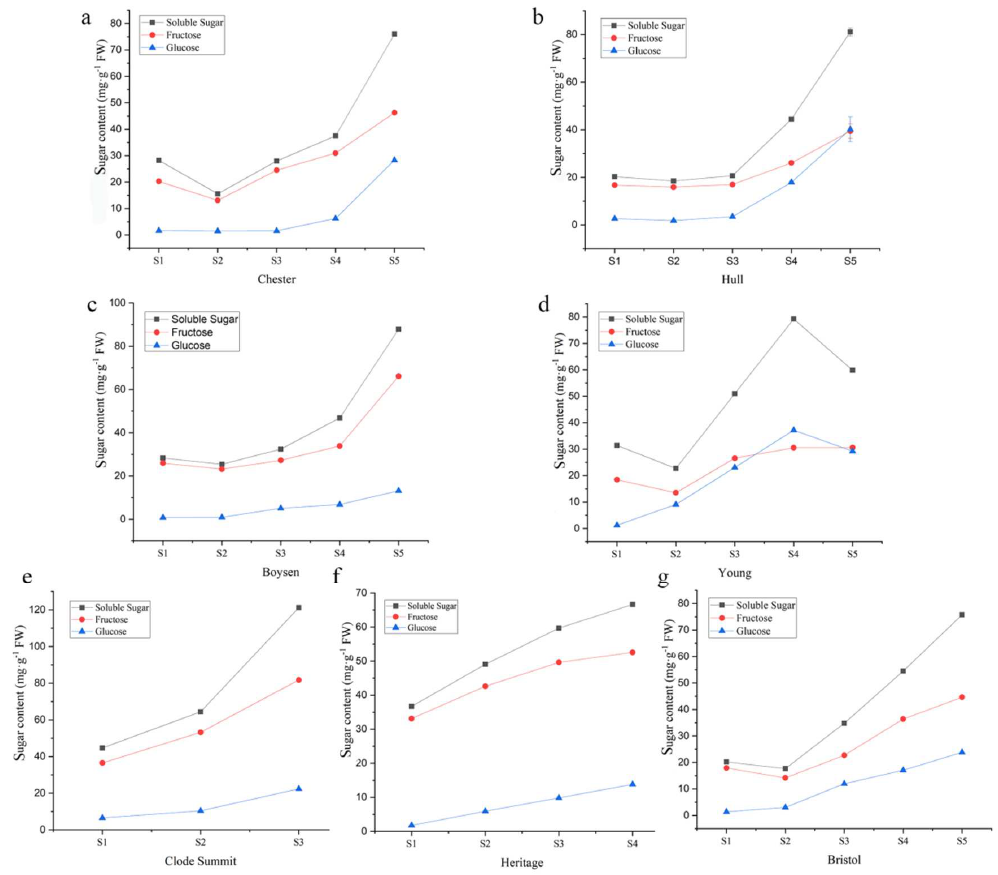
Figure 2. Variation in the sugar content in fruits of different Rubus cultivars at different developmental stages. ( a ) Chester; ( b ) Hull; ( c ) Boysen; ( d ) Young; ( e ) Clode Summit; ( f ) Heritage; and ( g ) Bristol. Black dashed lines represent soluble sugars, red dashed lines represent fructose, and blue dashed lines represent